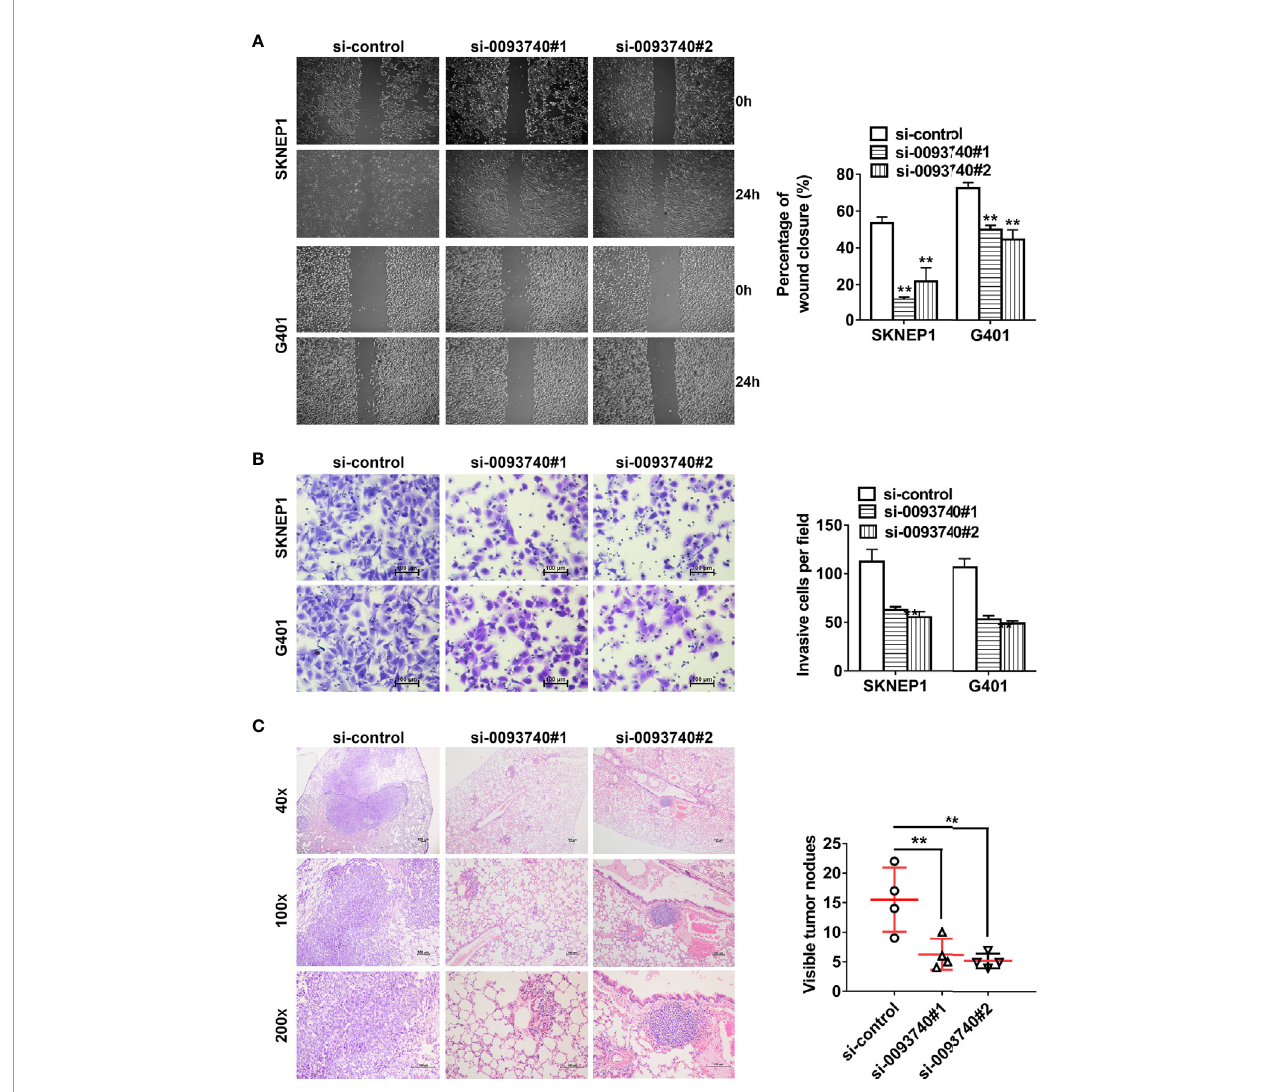
FIGURE 3 | Suppression of circ0093740 inhibits the metastasis of Wilms tumor cells. (A) Wound healing assays were conducted in SKNEP1 and G401 Wilms tumor cell line. (B) Transwell assay was performed to investigate the migration ability of SKNEP1 and G401 Wilms tumor cell line. (C) The number of lung metastases was counted and recorded. HE-stained tumor sections of lung metastases were presented. **p <